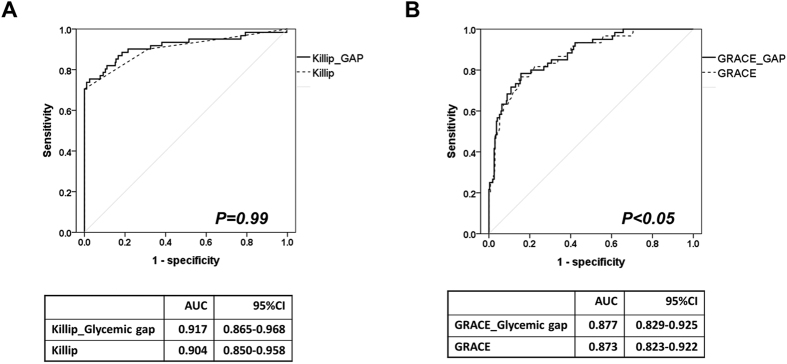
The effects of integrating glycemic gaps with the Killip classification and GRACE scores.